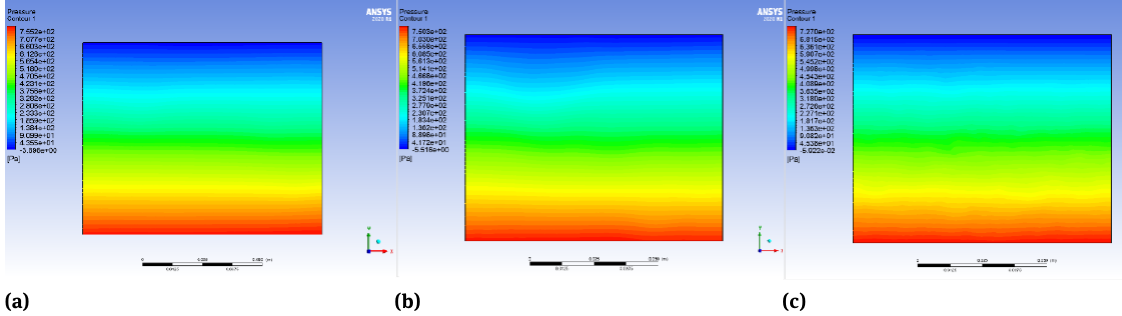
Figure 9: Pressure in 5 s. (a) Eulerian; (b) mixture; (c) VOF